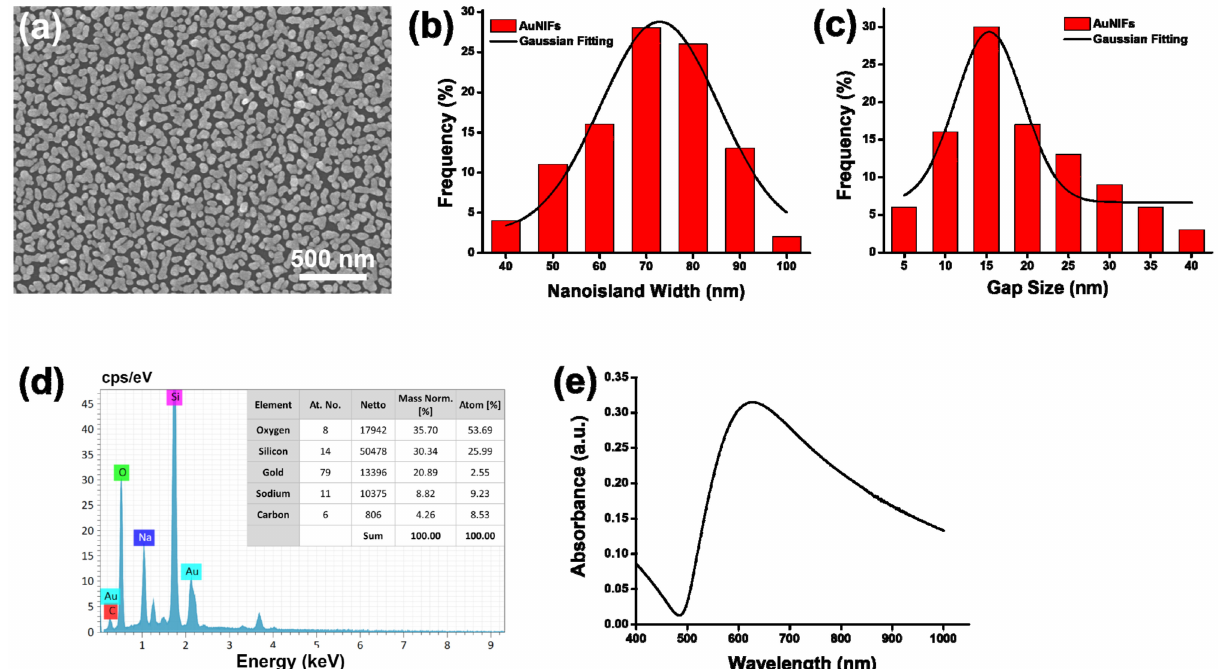
Figure 1. ( a ) SEM image of the gold nanoisland film (AuNIF), ( b ) the histogram of nanoisland width of AuNIF and its Gaussian-fitting curve, ( c ) the histogram of nanoisland gap of AuNIF and its Gaussian-fitting curve, ( d ) EDX spectrum of the AuNIF and elemental composition (inset table), and ( e ) UV-Vis spectrum of the